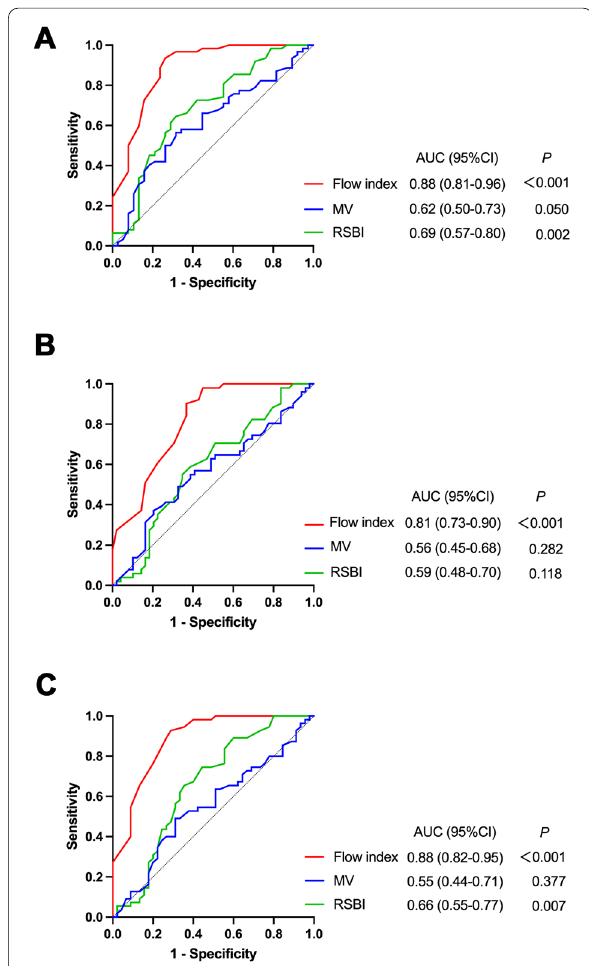
Fig. 4 Receiver operating characteristic curve of non‑invasive parameters for detecting low inspiratory effort. The area under the receiver operating characteristic curve (AUC) and 95% confidence interval (CI) are shown. By definition of work of breathing ( A ), the AUC of flow index was significantly higher than those of rapid shallow breathing index (RSBI) ( P 0.002) and minute ventilation (MV) = ( P < 0.001). By definition of esophageal pressure–time product per minute ( B ), the AUC of flow index was significantly higher than the other parameters (vs. RSBI: P